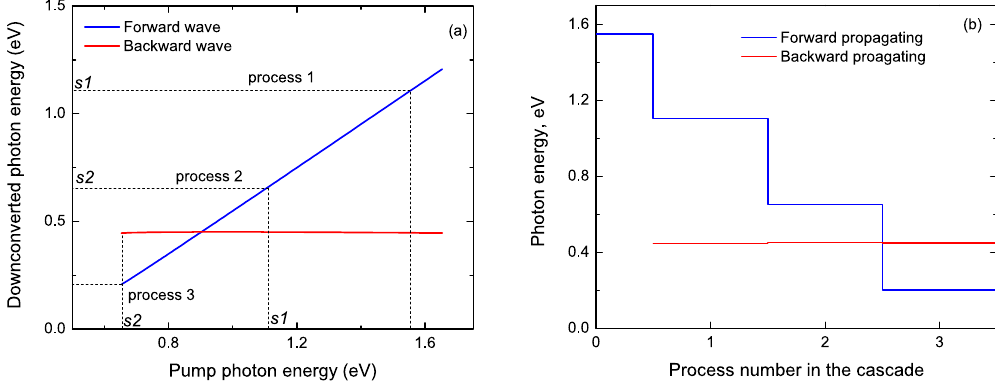
Figure 2. Calculated cascaded MOPO processes in a 755 nm-period PPRKTP with a primary pump-photon energy of 1.55 eV. ( a ) Cascade steps in the forward propagating photon energy as cascaded MOPO processes sequentially start oscillating. On the axes, s1 and s2 indicate the energy of the generated signals that are used as pumps for the consecutive cascades. Note that the energy of the backward-propagating photons remains relatively stable. ( b ) Energy levels of the generated photons in the cascaded